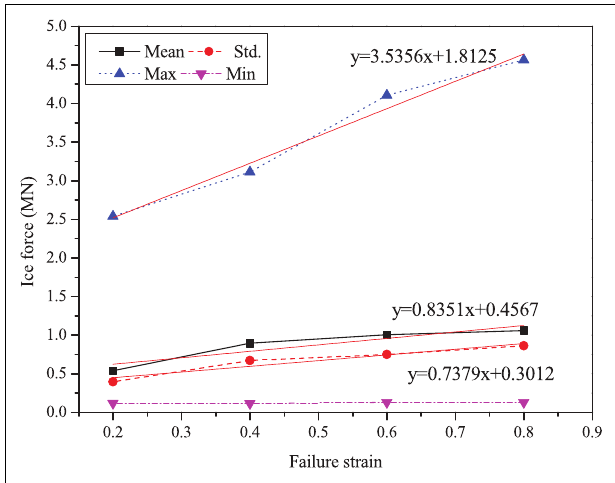
FIGURE 5 | Statistic results of the ice force in the F-A direction with variations of failure strain.